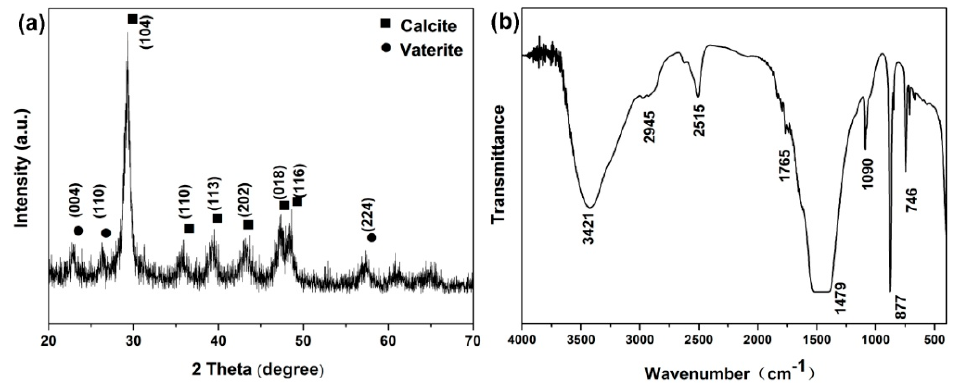
Figure 2. XRD patterns ( a ) and FTIR ( b ) spectrum of Rod-CC NPs.